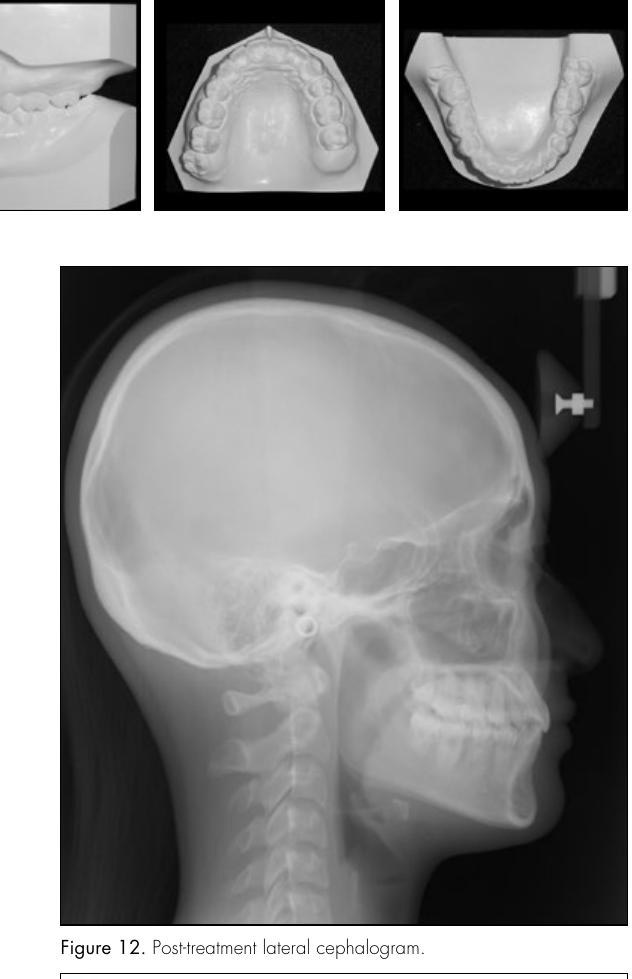
Figure 12. Post-treatment lateral cephalogram.